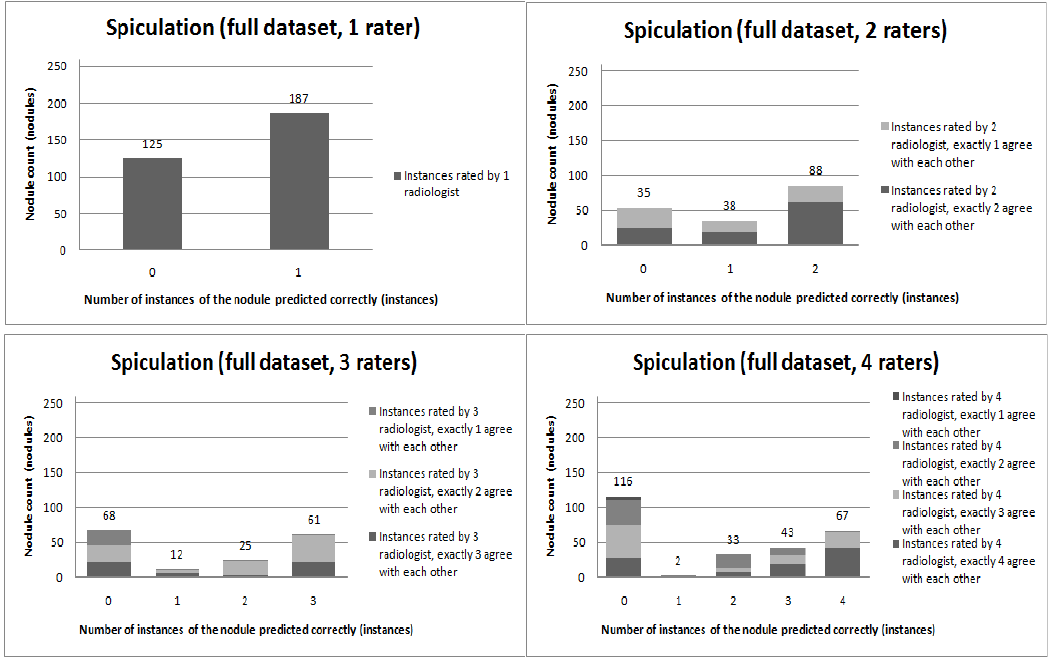
Figure 10. Visual overview of the ensemble of classifiers’ agreement with the panel of experts’ opinions (Spiculation).